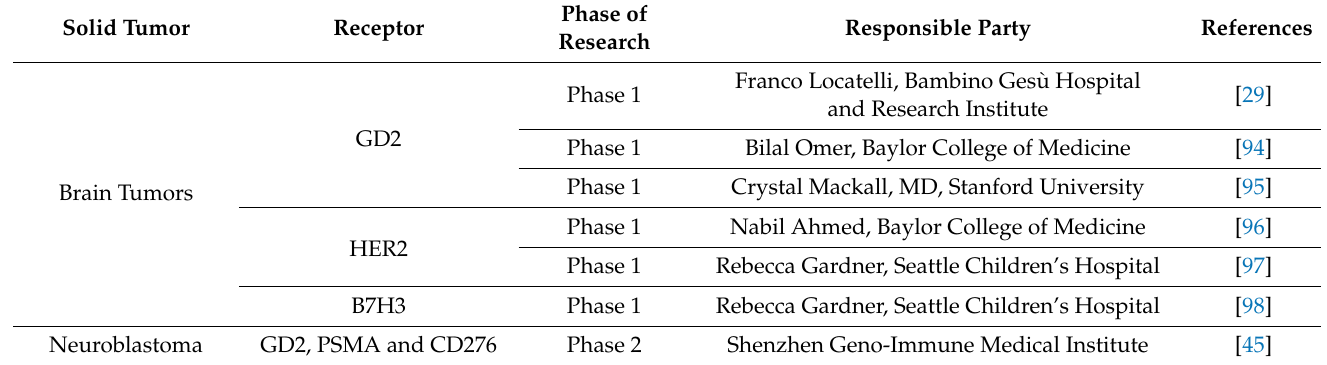
Table 2. All ongoing, recruiting clinical trials connected with CAR-T cell therapy in pediatric solid